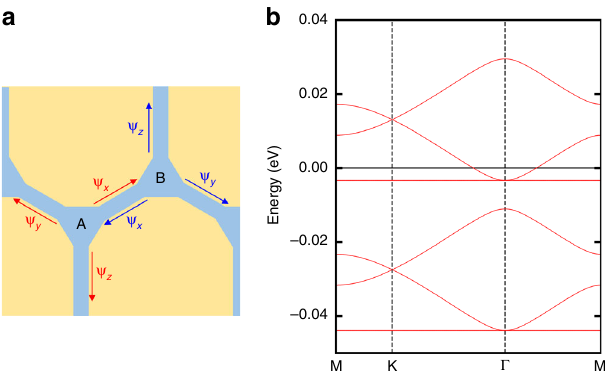
Fig. 5 Honeycomb lattice model of domain-wall network. a Unit cell of network model. A and B denote the sublattice sites. ψ a and ψ (cid:1) a represent the propagating direction of the modes. b Miniband structure ( v F ℏ = 0.545 eV Å and L = 42.24 Å). The value of v F ℏ is estimated by the band dispersion along the domain-wall direction of the DW-1 model. The same structures of minibands will repeat in energy to fi ll the entire Mott gap. Each one- dimensional bands inside the domain walls contribute a set of the minibands with different parameters, and hence we expect that many minibands will overlay each other in